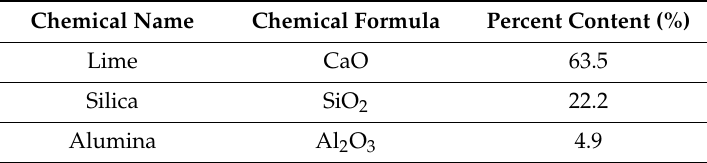
Table 1. Chemical properties of OPC 53 grade cement